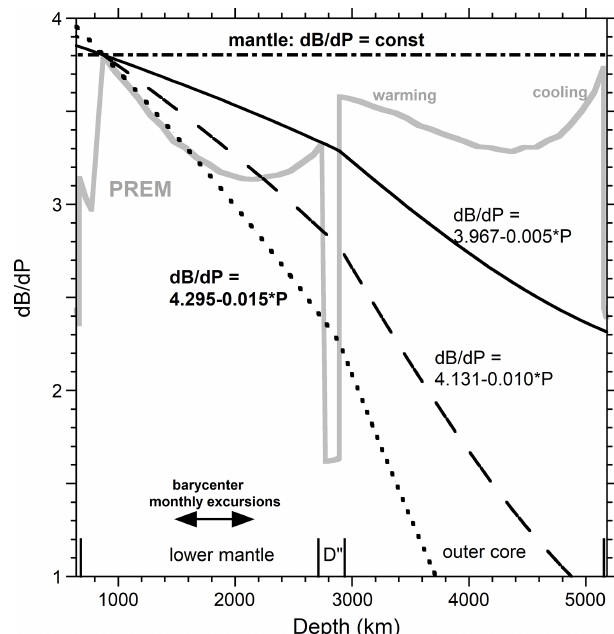
Figure 5. Construction of possible curves for the depth response of the P component of mantle ∂B/∂P at 871km and deeper. The edges of the transition zone and inner core define the x axis. Dis- continuities shallower than 871km and in D (cid:48)(cid:48) are not addressed in our approach. If ∂ 2 B/∂P 2 is small, near 0, then PREM indicates that warming first occurs as z increases but at greater depths tem- peratures decrease. This behavior describes the LM and outer